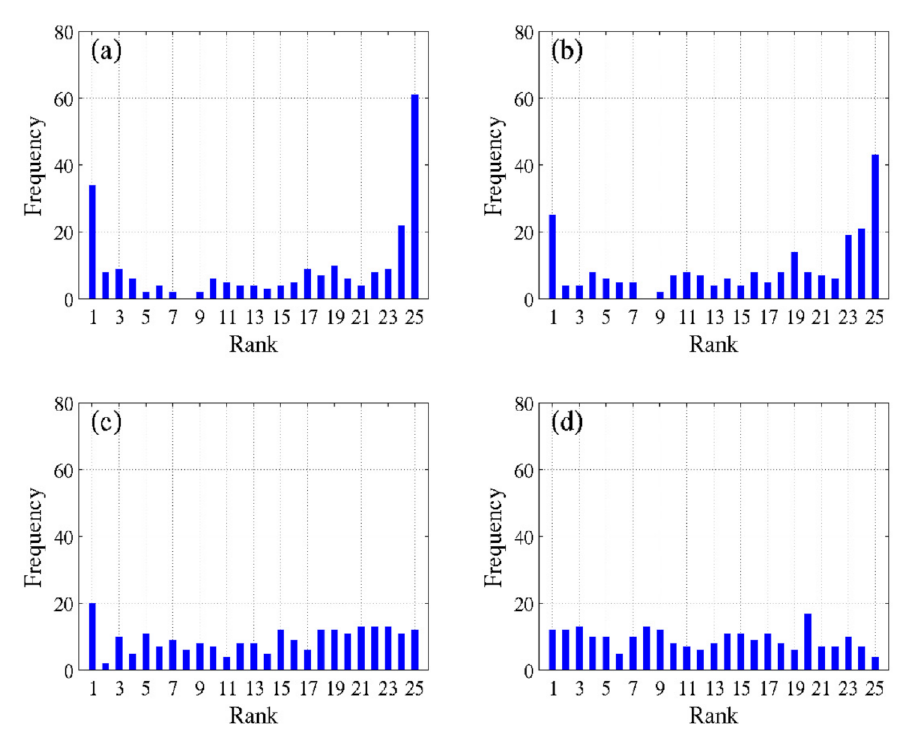
Figure 6. Rank histogram to determine the suitability of ensemble spread for all observation points with forecasting lead times of ( a ) +00 h, ( b ) +24 h, ( c ) +48 h, and ( d ) +72 h.